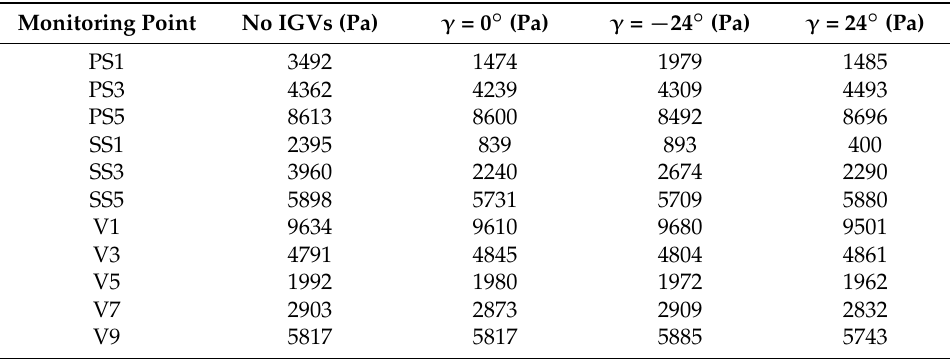
Table 5. Pressure RMS values in pumps with different prewhirl